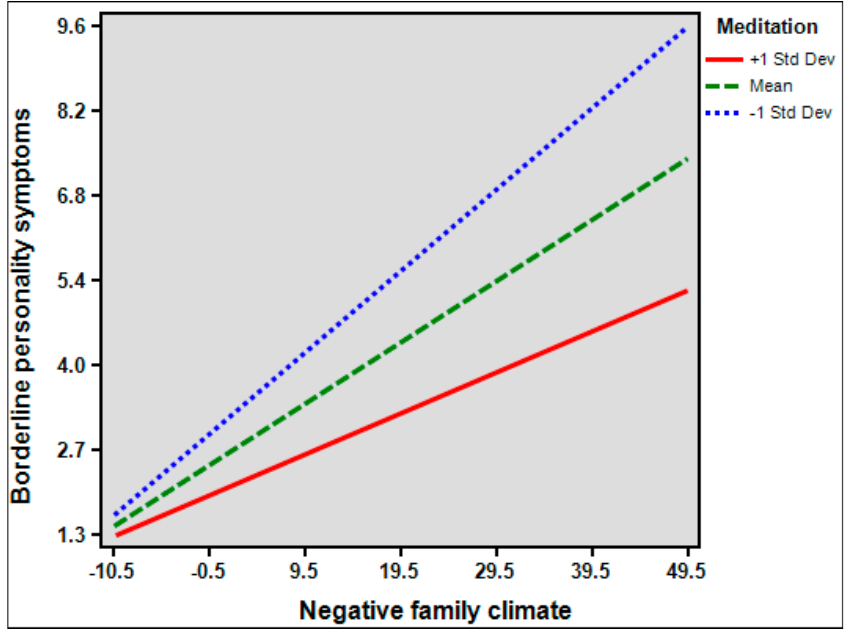
Figure 3. Borderline personality disorder symptoms as a function of the interaction between Negative Family Climate and meditation.